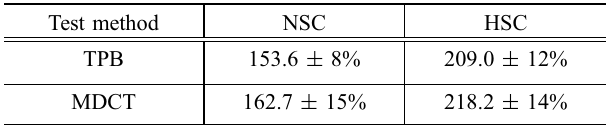
Table 7 Summary of results of G F for the two concrete mixes NSC and